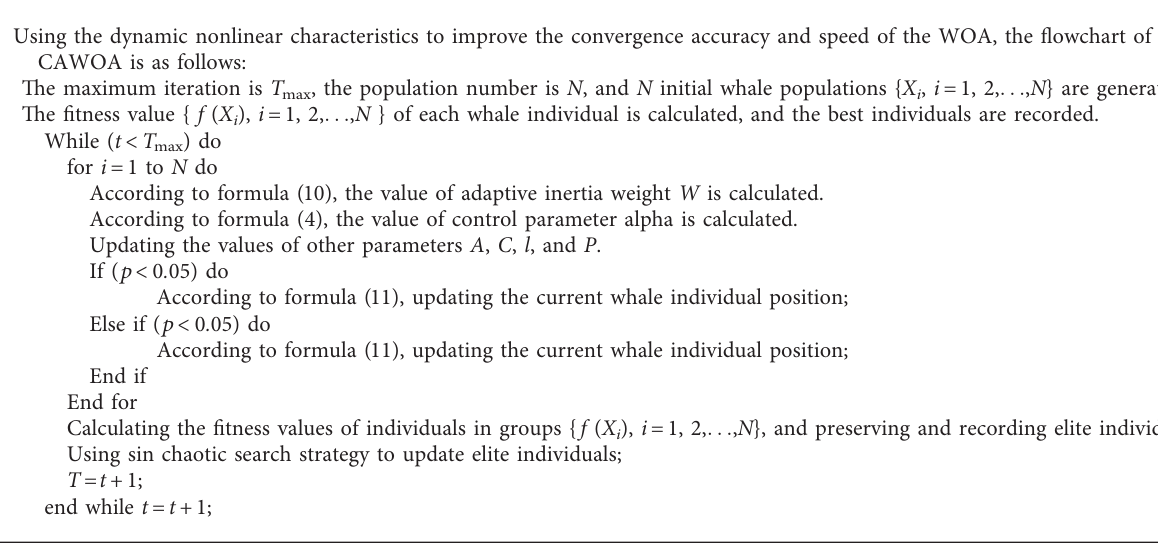
A LGORITHM 1: CAWOA algorithm